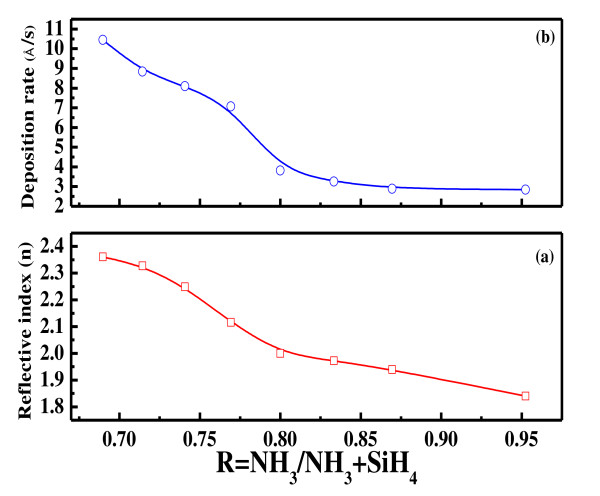
Refractive index (a) and deposition rate (b) of SiNX:H film at various NH3/NH3+SiH4 gas ratios.